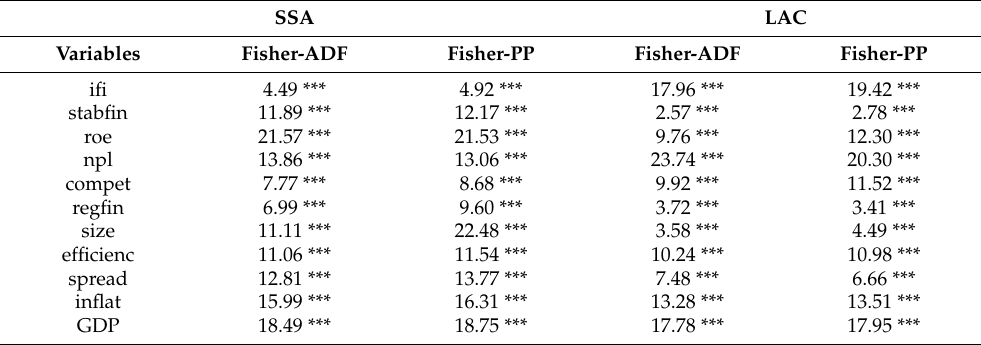
Table 7. Panel unit root test.